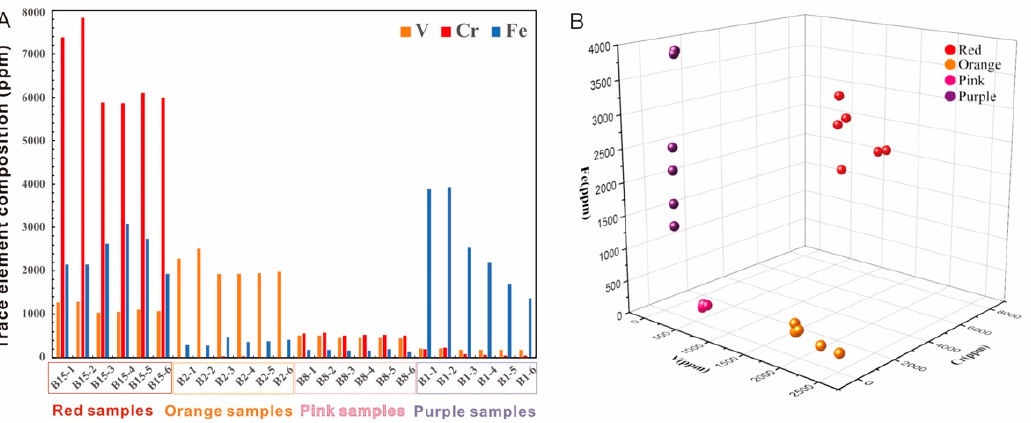
Figure 12. Histogram ( A ) and 3D scatter plots of Cr–V–Fe compositions ( B ) of Mogok spinel. The total content of Cr+V in warm-color-system (red, pink and orange) spinel sam- ples is high. The content of Cr+V in cold-color-system (purple) spinel samples is generally low (Figure 13B). In warm-color-system spinel, the lower the contents of Cr and V, the lighter the red tone of the spinel. The orange tone of spinel is related to the V and Cr content. As shown in Figure 13A, by comparing the contents of Cr and V, the V/Cr ratios of orange spinel samples are all greater than 1. Therefore, V plays a dominant role in the orange tone of spinel. In the cool color system (purple) of spinel, the lower the Fe content, the lighter the blue tone of the sample and the higher the Fe content, the stronger the blue tone of the sample (Figure 13B).